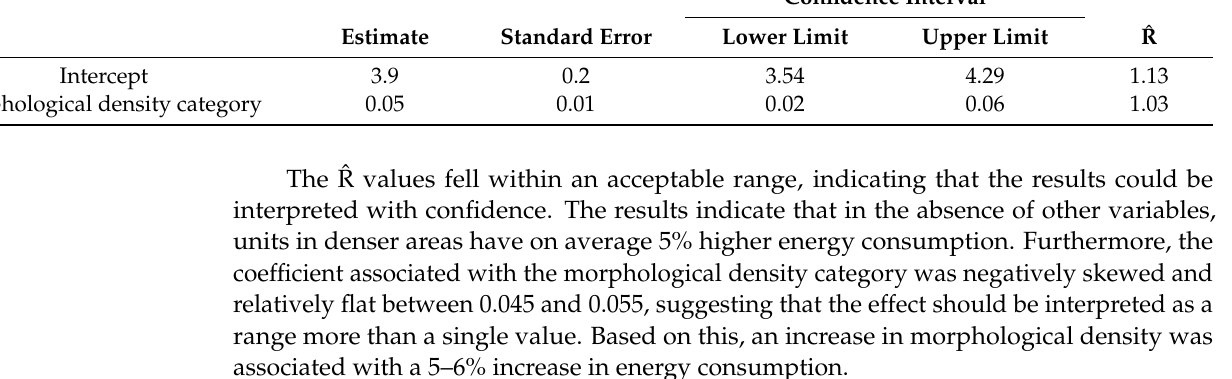
Table 6. Population level effects: the simplified Bayesian hierarchical spatial model. Confidence Interval Estimate Standard Error Lower